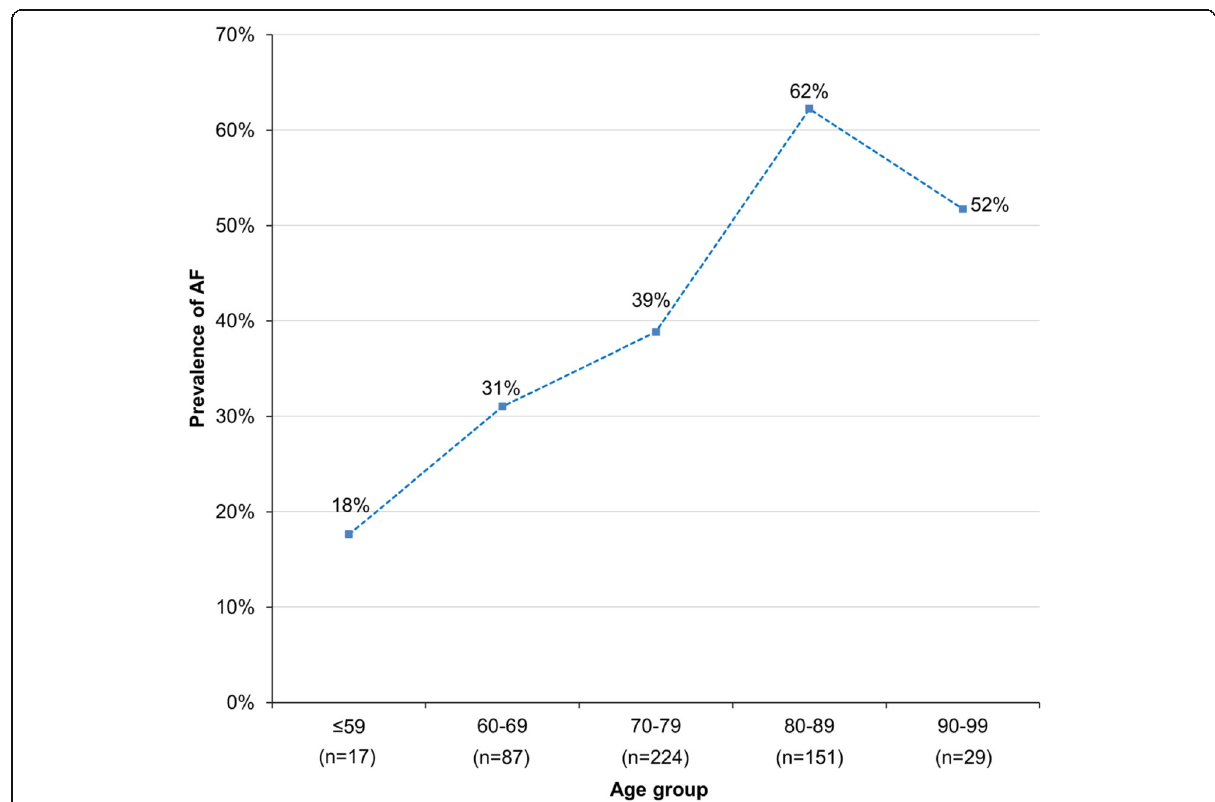
Fig. 3 Prevalence of AF (based on both acute care work-up and post-acute second-look 24 h ECG) relative to age (x-axis) in patients with ischemic stroke requiring inpatient neurorehabilitation (number of patients per age group in